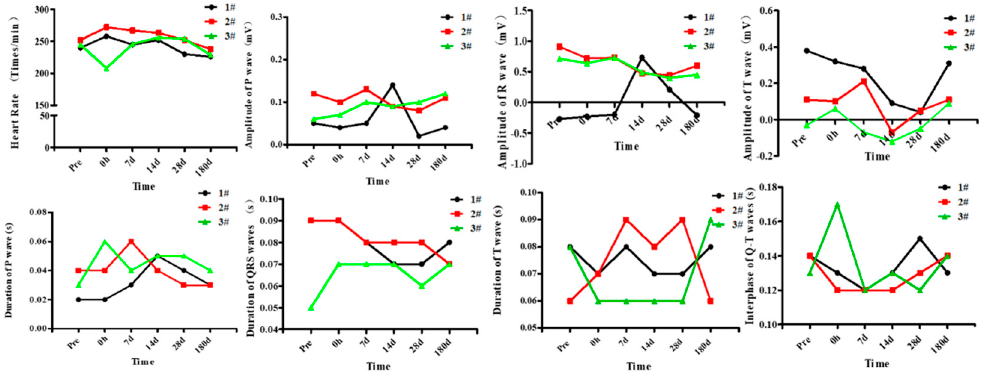
Figure 3. Effects of high level noise on ECG of macaque monkeys. Table 1. Value of the ECG parameters at each time points (M ± SD).